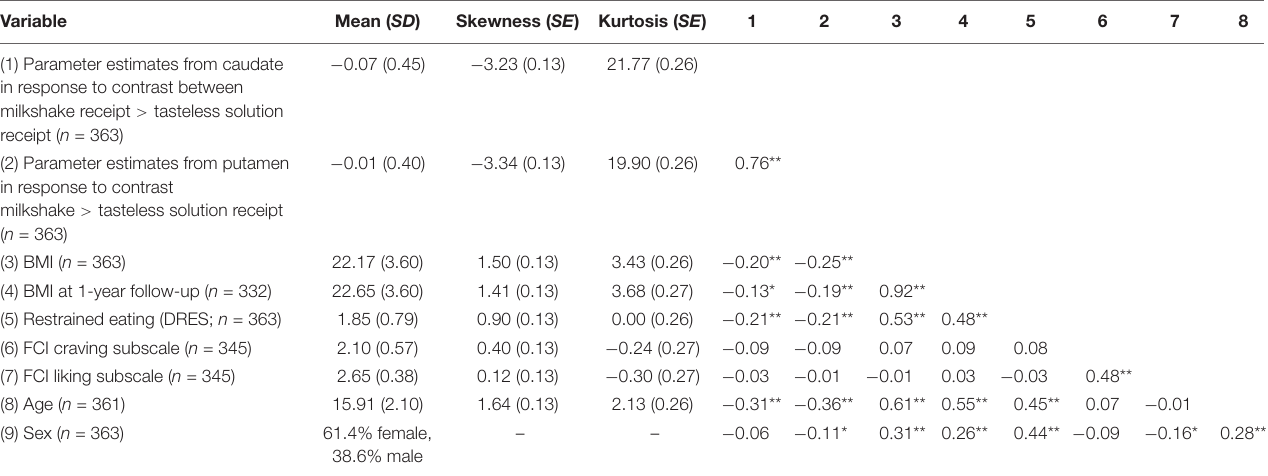
TABLE 1 | Descriptive statistics and correlations for the full sample ( N = 363). Variable